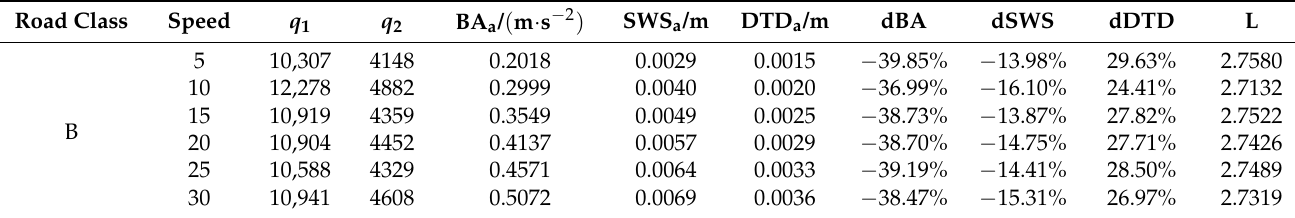
Table 8. Optimal solution and simulation results of comfort mode under B-class road.